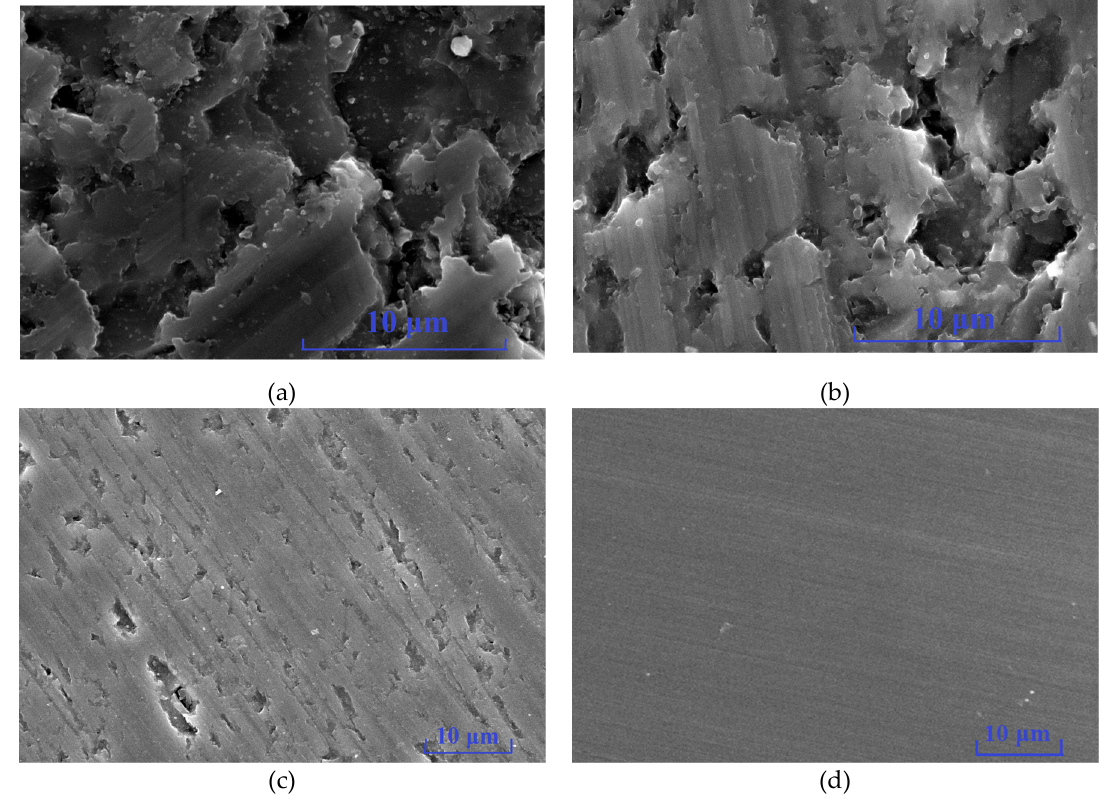
Figure 7. Morphology of Single crystal 6H-SiC substrates ground with different grades of grit ( a ) No.1 (Ra 0.303 µm), ( b ) No.2 (Ra 0.029 µm), ( c ) No.3 (Ra 0.015 µm) and ( d ) No.4 (Ra 0.002 µm). (Ra 0.303 µ m), ( b ) No.2 (Ra 0.029 µ m), ( c ) No.3 (Ra 0.015 µ m) and ( d ) No.4 (Ra 0.002 µ